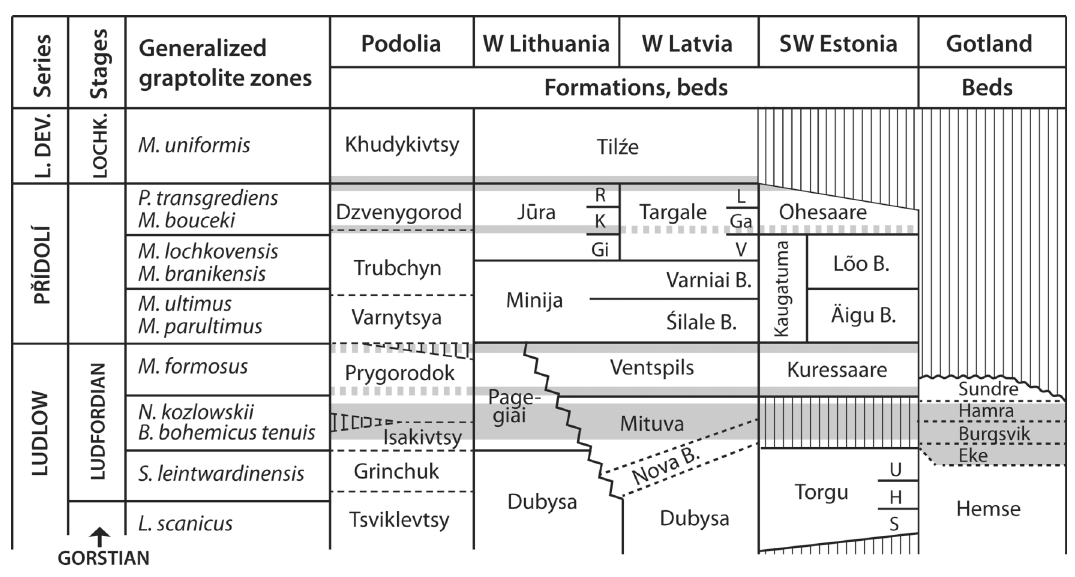
Fig. 2. Baltic(cid:150)Podolian lithostratigraphical nomenclature and bio- and chemostratigraphical correlation chart. For explanations see text. Abbreviations: L. Dev. (cid:150) Lower Devonian; Lochk. (cid:150) Lochkovian; Beds in the Jura Fm: R (cid:150) Rietavas, K (cid:150) Kelme, Gi (cid:150) Gird(cid:158)iai; in the Targale Fm: L (cid:150) Lu(cid:158)ni, Ga (cid:150) Garzde, V (cid:150) Venzava; in the Torgu Fm: U (cid:150) Uduvere, H (cid:150) Himmiste, S (cid:150) Sauvere. Generalized graptolite zones according to Koren et al. (1996). Grey lines (disruped when doubtful) are chemostratigraphic event or correlation lines, discussed in detail in the (cid:145)Discussion(cid:146) section of the